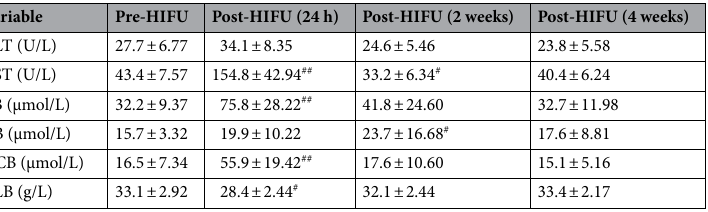
Table 3. Pre-HIFU and post-HIFU liver function. HIFU high intensity focused ultrasound, ALT alamine aminotransferase, AST aspertate aminotransferase, TB total bilirubin; CB, conjugated bilirubin, UCB unconjugated bilirubin, ALB aluminum. # Compared with pre-HIFU values, p < 0.05. ## Compared with pre- HIFU values, p <